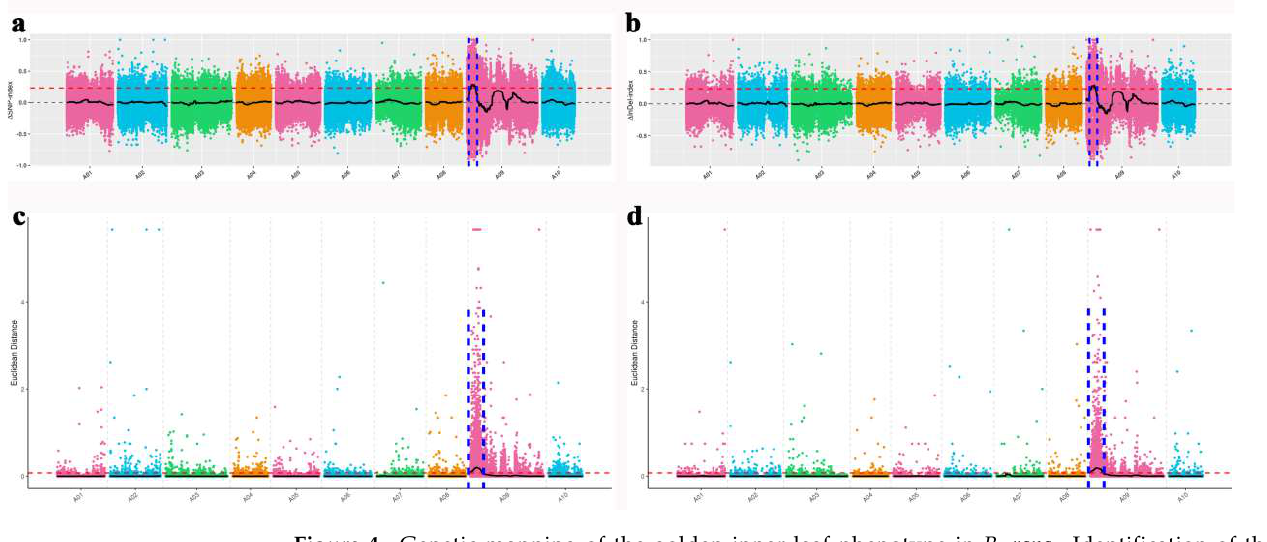
Figure 4. Genetic mapping of the golden inner leaf phenotype in B . rapa . Identification of the BrGOLDEN candidate region through the △ SNP index ( a ) and △ InDel index; ( b ) association analysis method. BrGOLDEN candidate regions identified by Euclidean distance (ED) and SNP ( c ) or ED and InDel ( d ) association analysis. The higher the index value or ED value, the better the association effect.